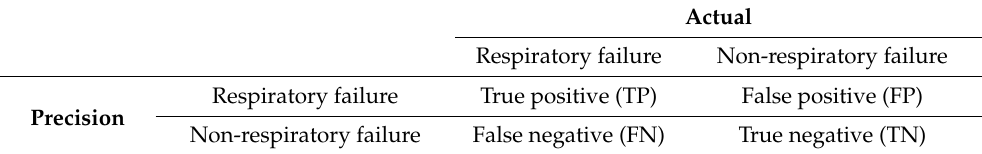
Table 5. Confusion